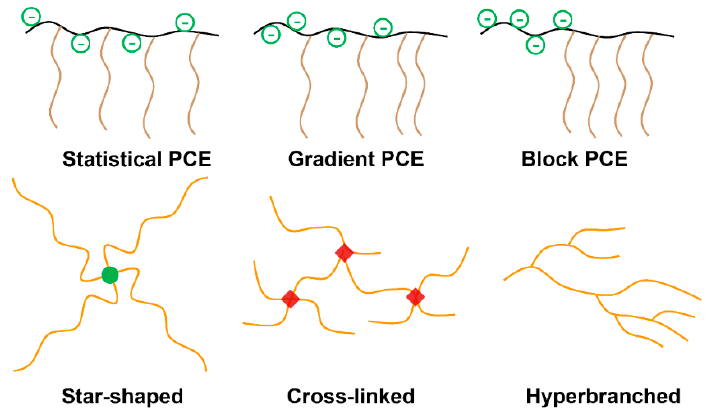
Figure 9. Topological structure of superplasticizers; each orange line in the bottom images represents the basic PCE structure (side chain omitted to simplify the figure).